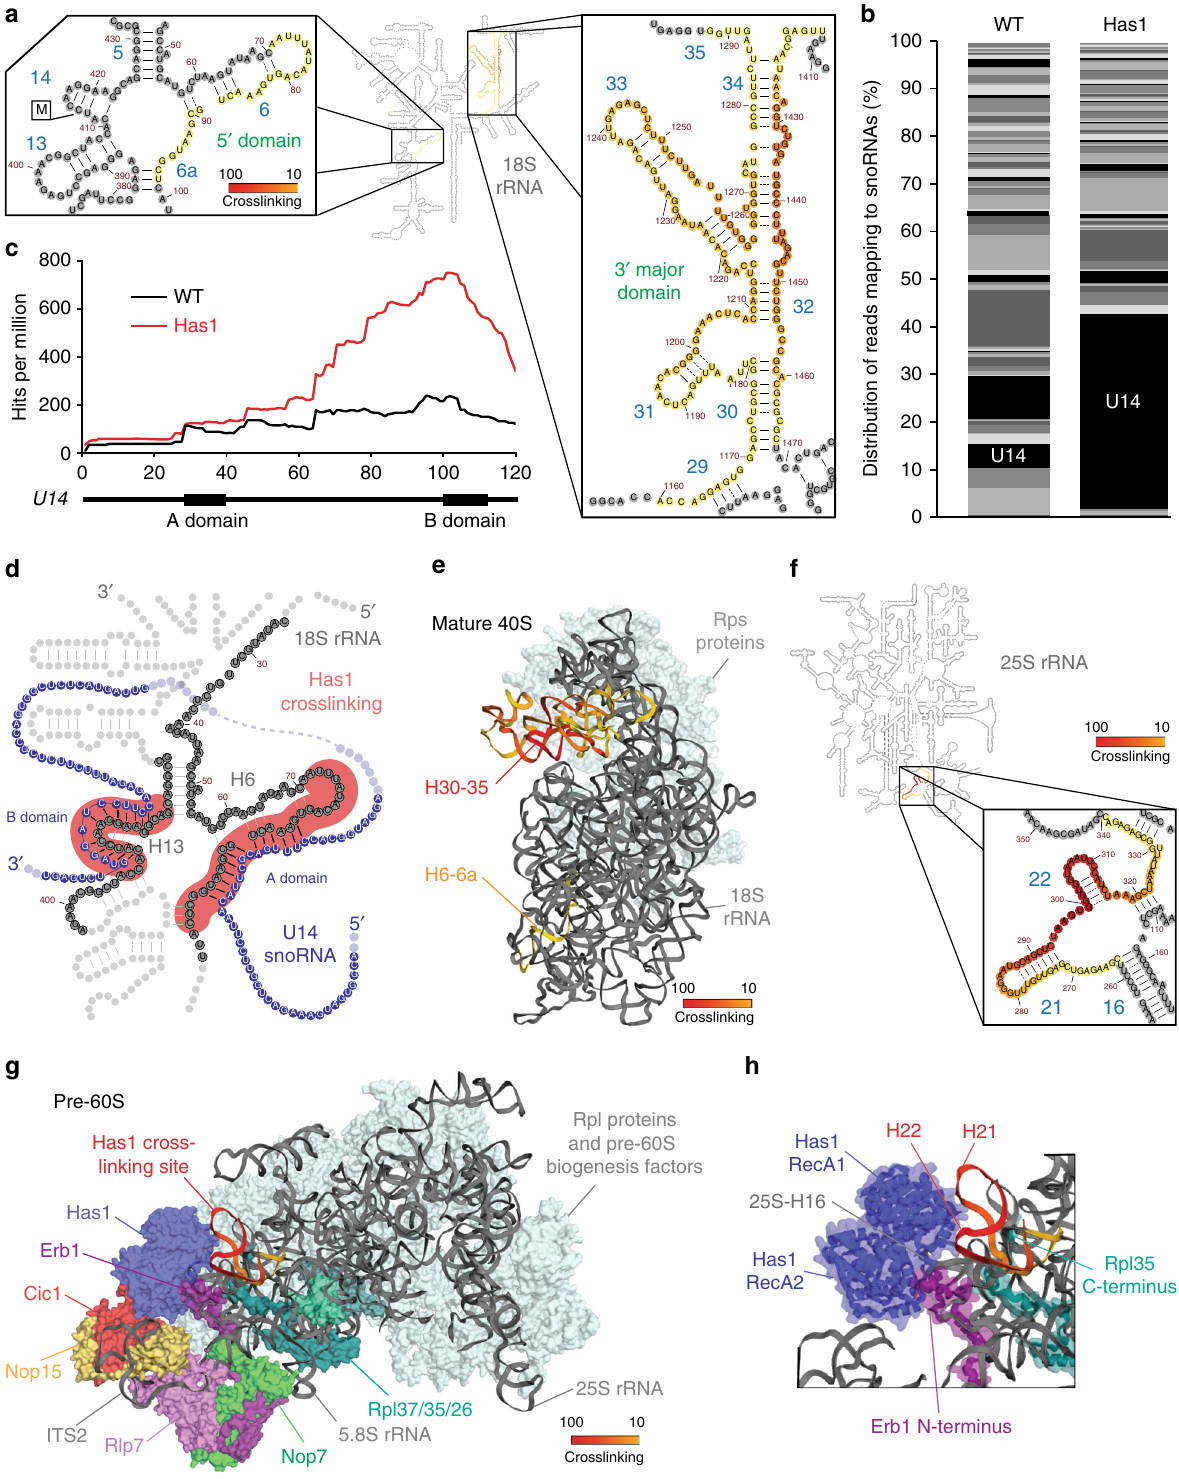
control sample re fl ect the distribution of non-speci fi cally co- puri fi ed (i.e. background) RNAs that are carried through the CRAC procedure. Our analysis revealed that compared to the control, the amount of rRNA sequences retrieved with Has1, Mak5 and Spb4 were markedly increased (WT - 36%, Has1 - 76%, Mak5 - 59%, Spb4 - 42%), consistent with their involvement in ribosome assembly. The proportion of sequence reads in the